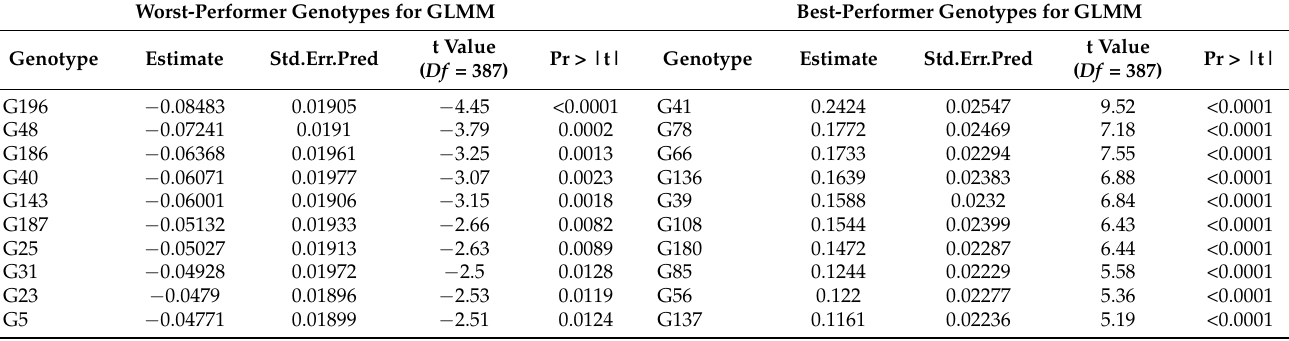
Table 6. Genotype performance for